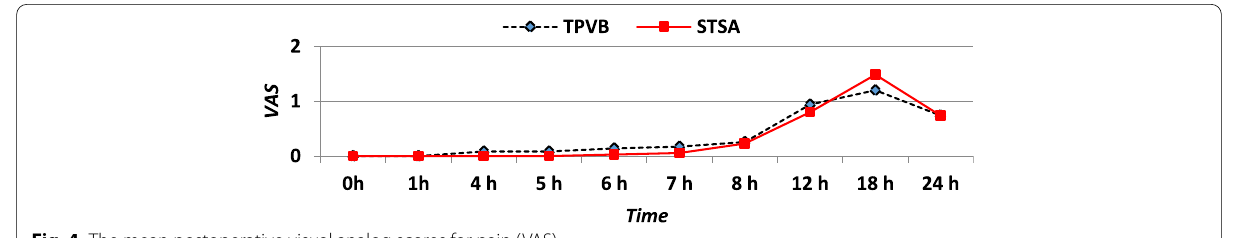
Fig. 4 The mean postoperative visual analog scores for pain